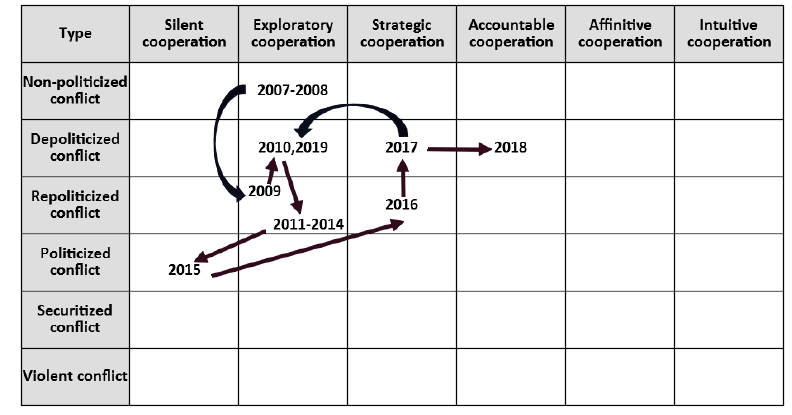
Figure 1. TWINS analysis–overall interstate relations.